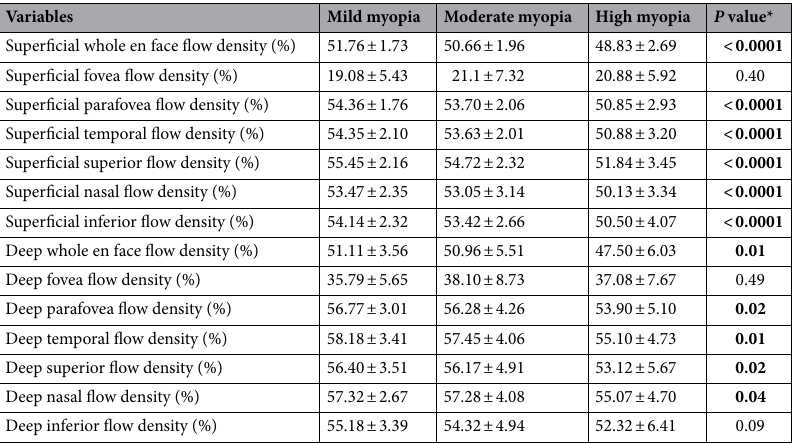
Table 2. The vascular density in each area of the macula. ANOVA, analysis of variance. Significant P values are in bold. *All calculated by one-way ANOVA.